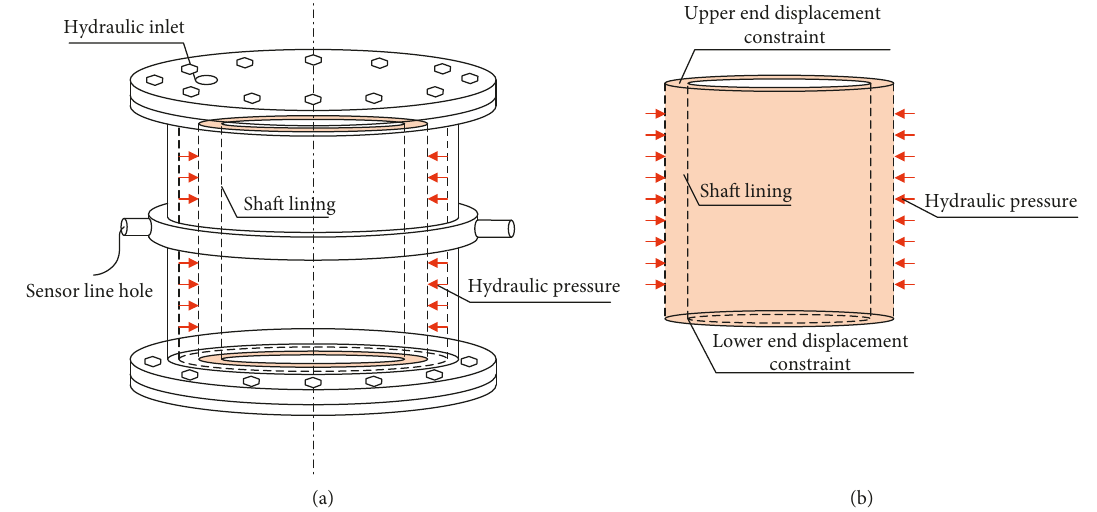
Figure 3: Schematic diagram of shaft lining model loading device.